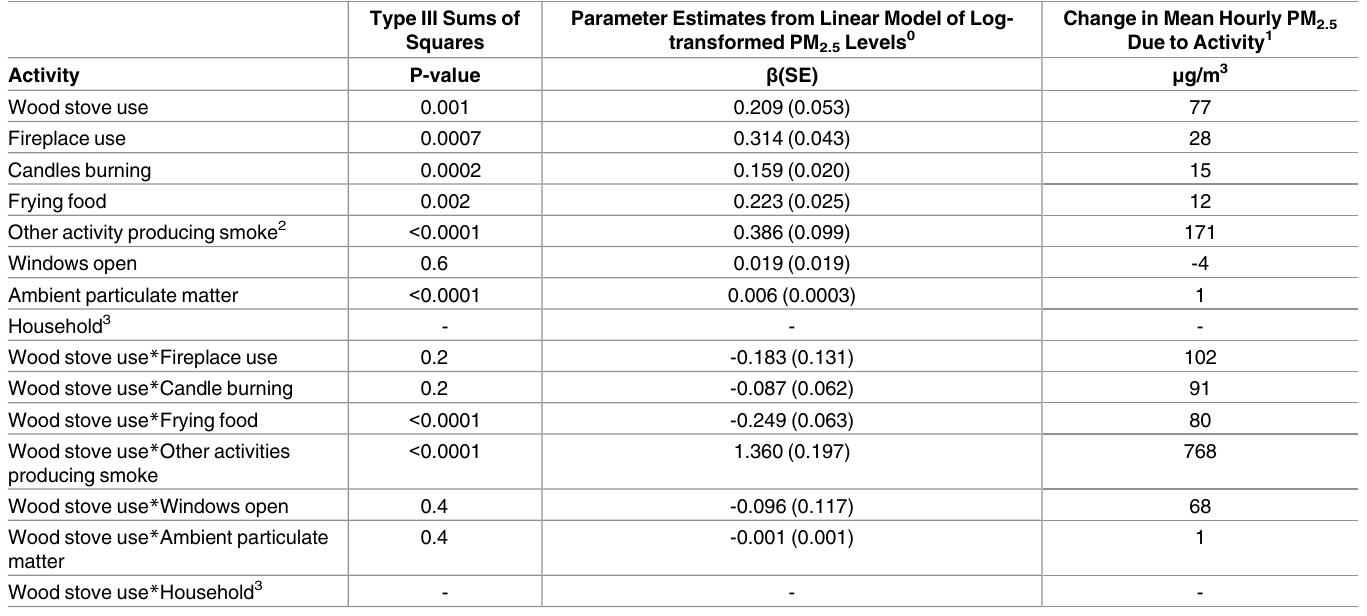
Table 3. Linear Model of Log-transformed Mean Hourly PM 2.5 Levels Including Reported Particulate Matter Generating Activities Concomitantly.